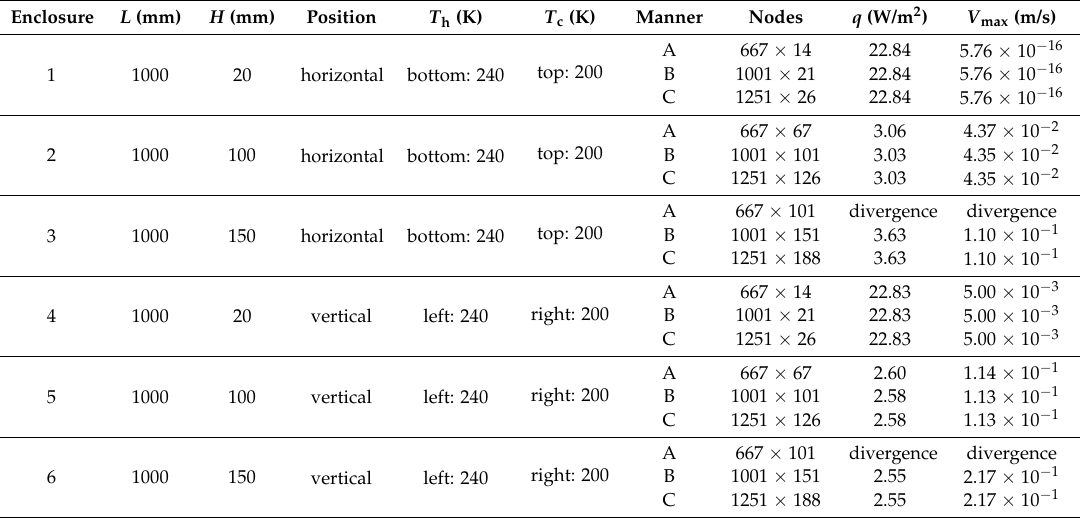
Table 1. Grid sensitivity test model and